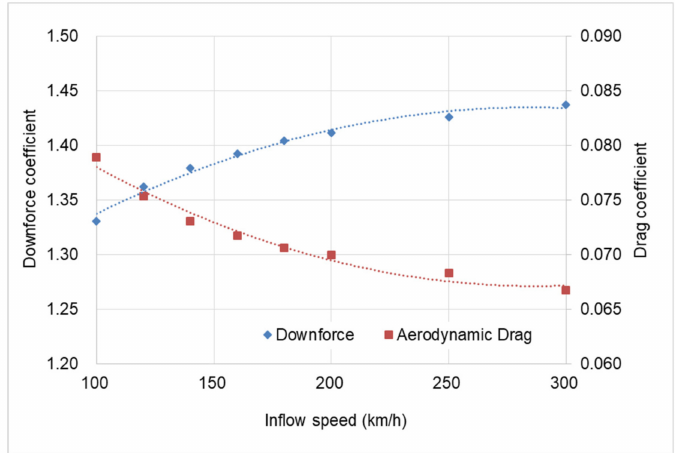
Figure 5. Aerodynamic drag and downforce coe ffi cients of rear spoiler with respect to various inflow